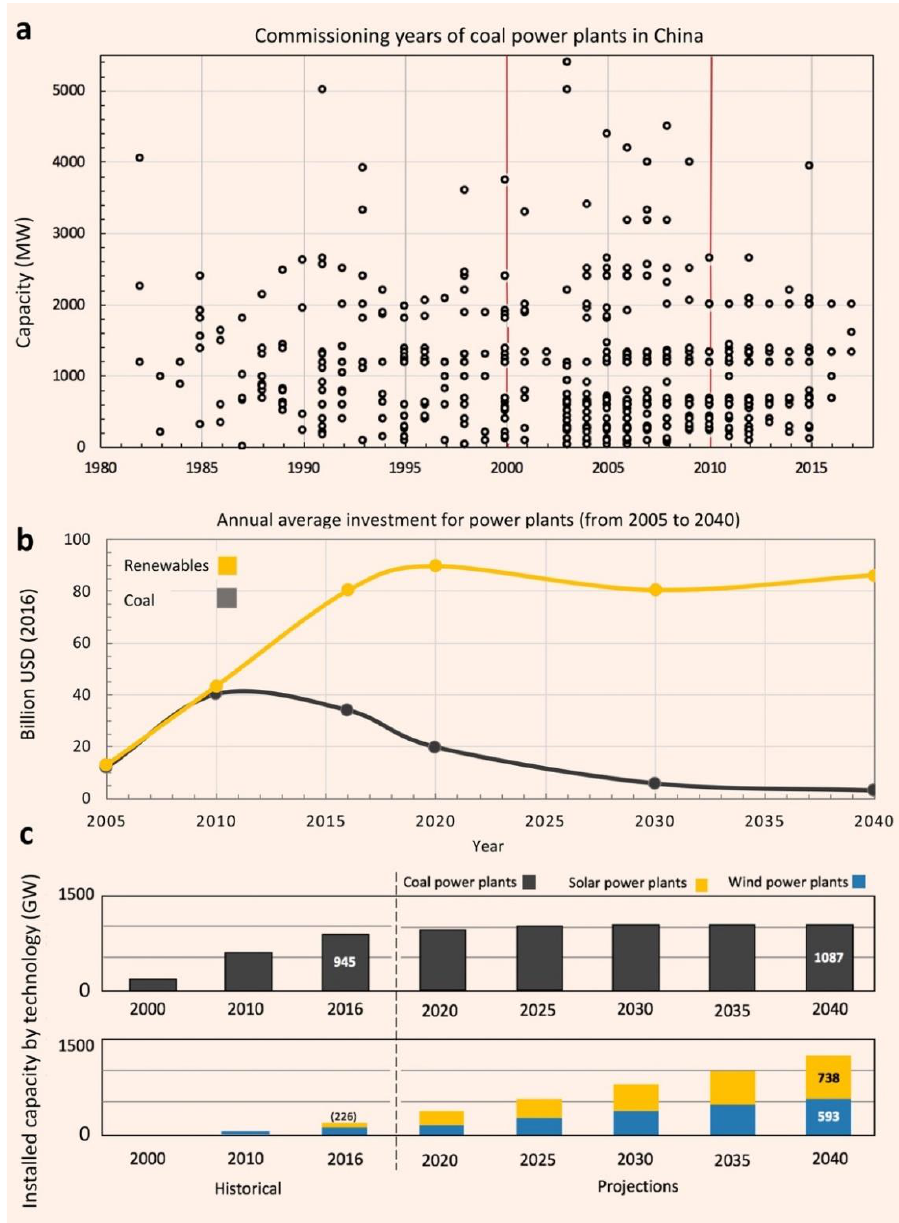
Figure 1. In this figure, the commissioning years and the capacities of coal power plants. ( a ) as well as the average annual investment in renewable energies and coal ( b ) are shown. The historical and projected installed capacities of coal compared to wind and solar power plants are also demonstrated ( c ). As seen 2000 – 2010 period, between the two redlines in ( a ), shows the highest number of coal power plants commissioned within the past 40 years.